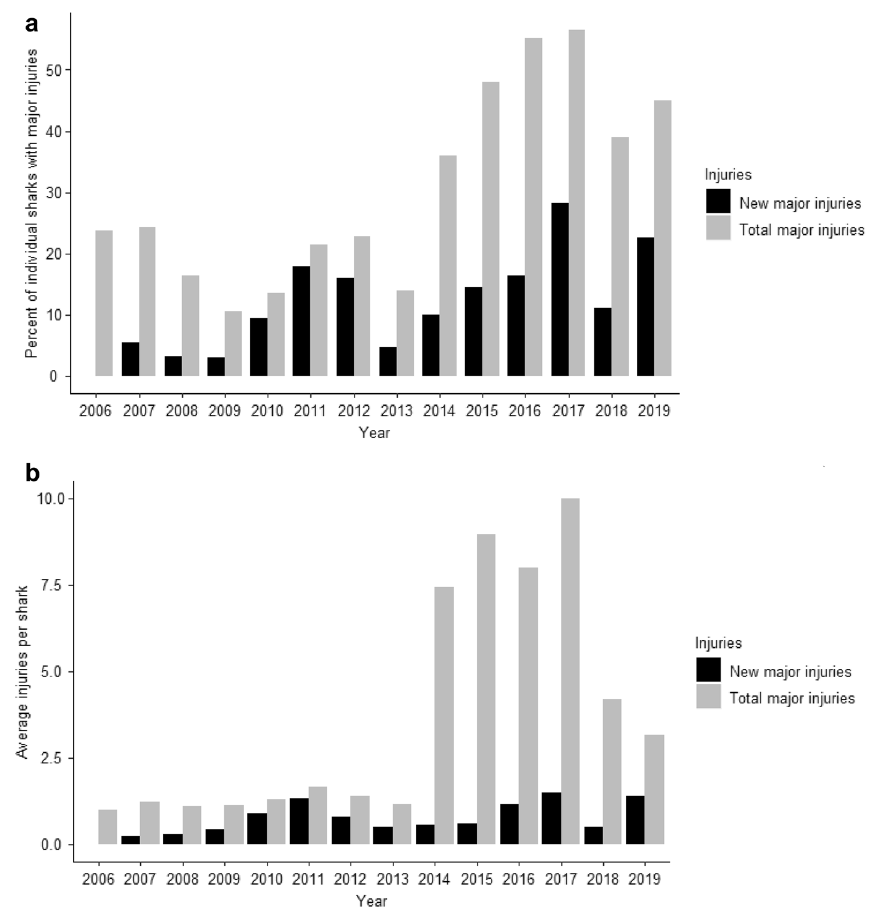
Figure 3. ( a ) Percentage of individual sharks from MWSRP data only sighted in a year with a new major injury (black) or any major injury (grey). ( b ) Average major injuries per injured shark. The maximum injuries observed on one individual was 49 during